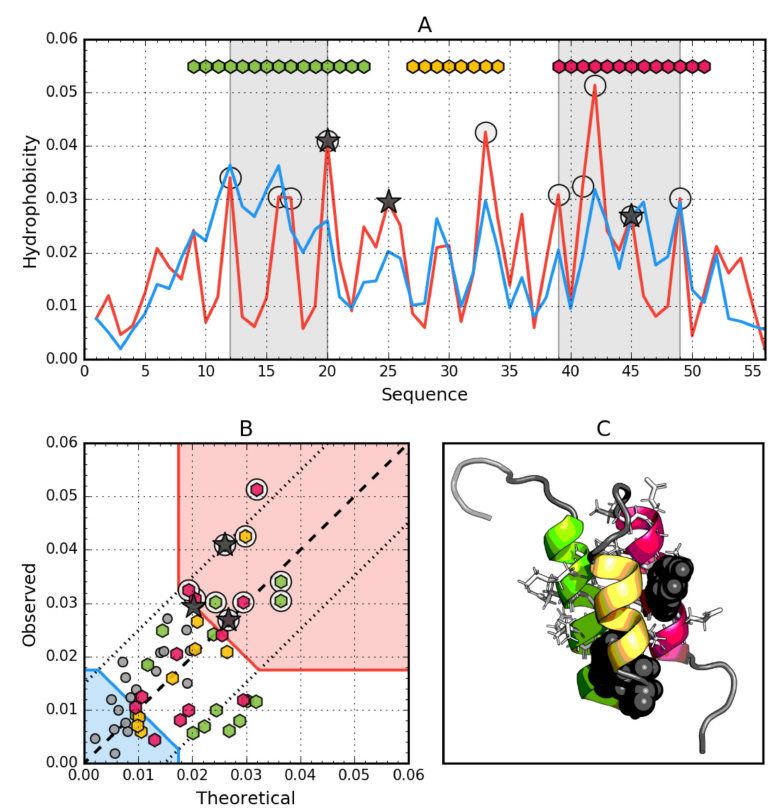
Figure 2. Hydrophobic properties of Ga98 (2LHC). ( A ) theoretical ( T —Blue) and observed ( O —Red) hydrophobicity density profiles. Markers at the top denote individually colored elements of